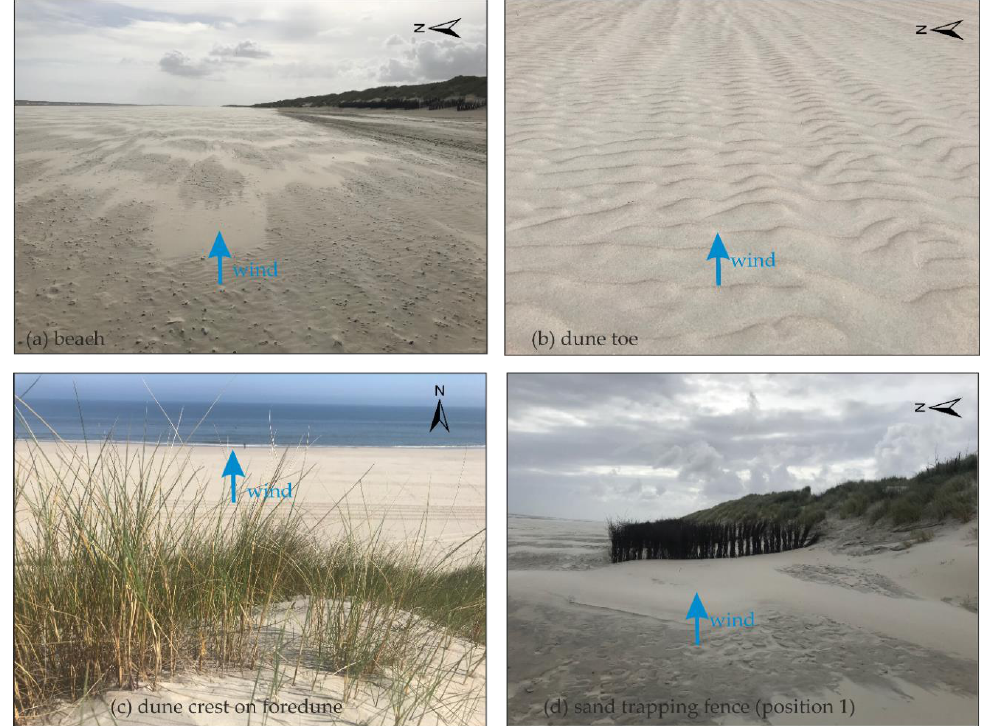
Figure 4. Closer visual impression of the measurement location at the ( a ) beach, ( b ) dune toe, ( c ) dune crest on the foredune, and ( d ) sand trapping fence (position 1) on Langeoog, Germany. Blue arrows indicate the respective wind direction during measurements at each measurement location.